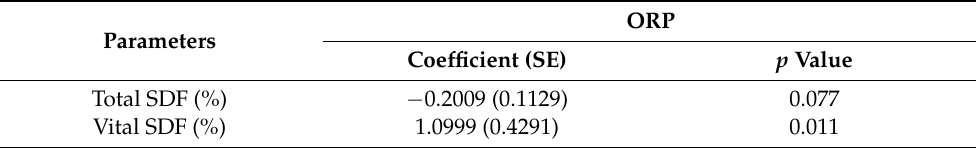
Table 4. Multiple regression analyses between ORP and SDF parameters.